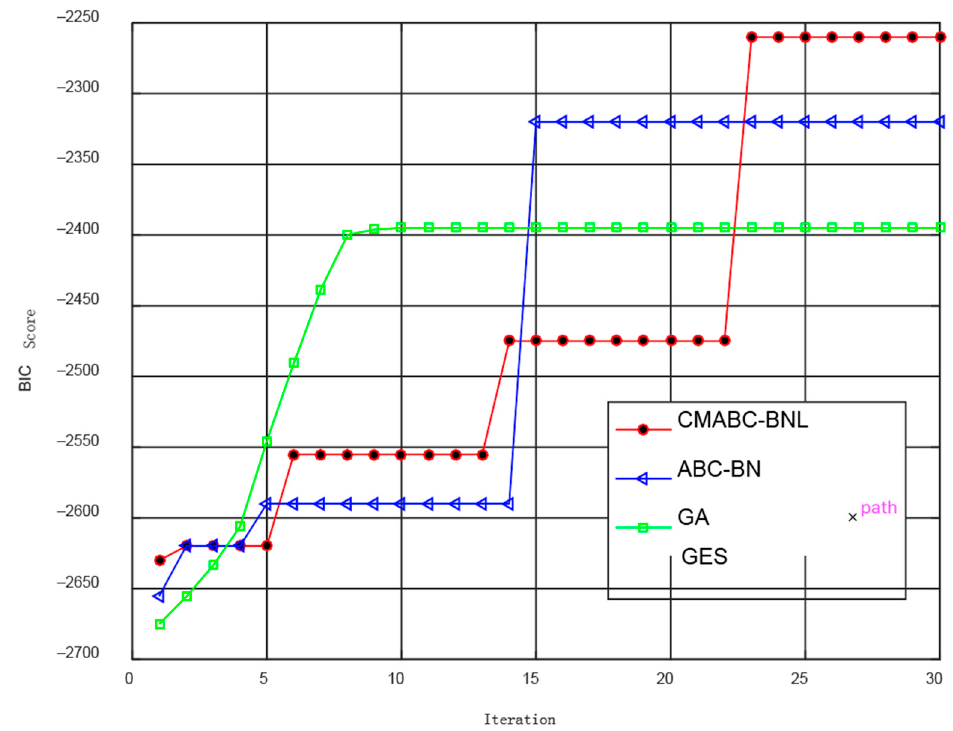
Figure 8. ASIA experiment results under 1000 data sets.